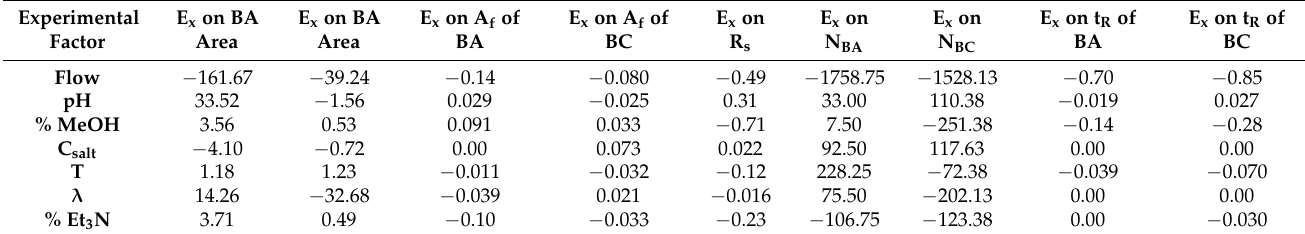
Table 4. Summarization of the effect of a given factor on each one of the monitored responses. Experimental Factor